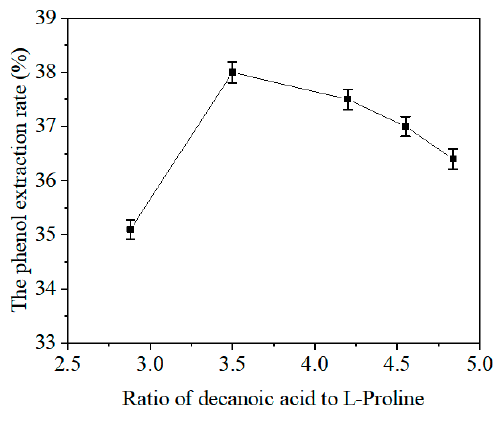
Figure 7. Effect of precursor molar ratio on phenol extraction rate.